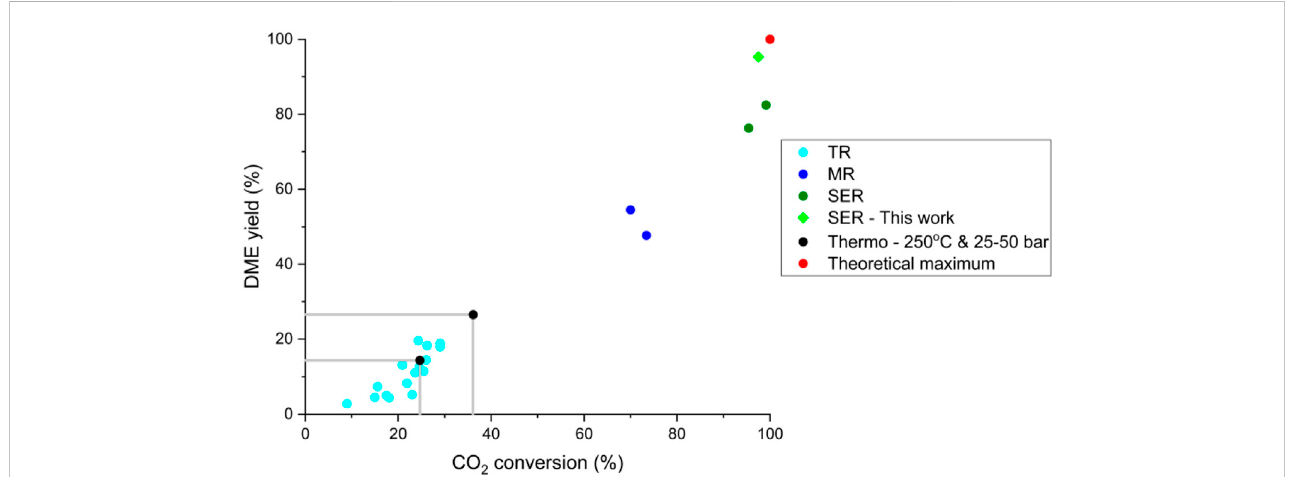
FIGURE 4 Comparison of experimental CO 2 conversion and DME yield for sorption enhanced reactors (SER; green) and membrane reactors (MR; dark blue) with results for traditional reactors (TR; light blue), reported in the open literature. Adapted from (van Kampen et al., 2021a).